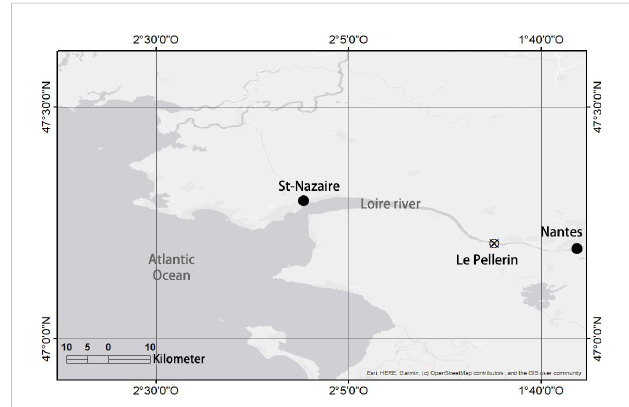
FIGURE 1 Map of the Loire estuarine region. The Le Pellerin sampling site is indicated by a crossed circle.